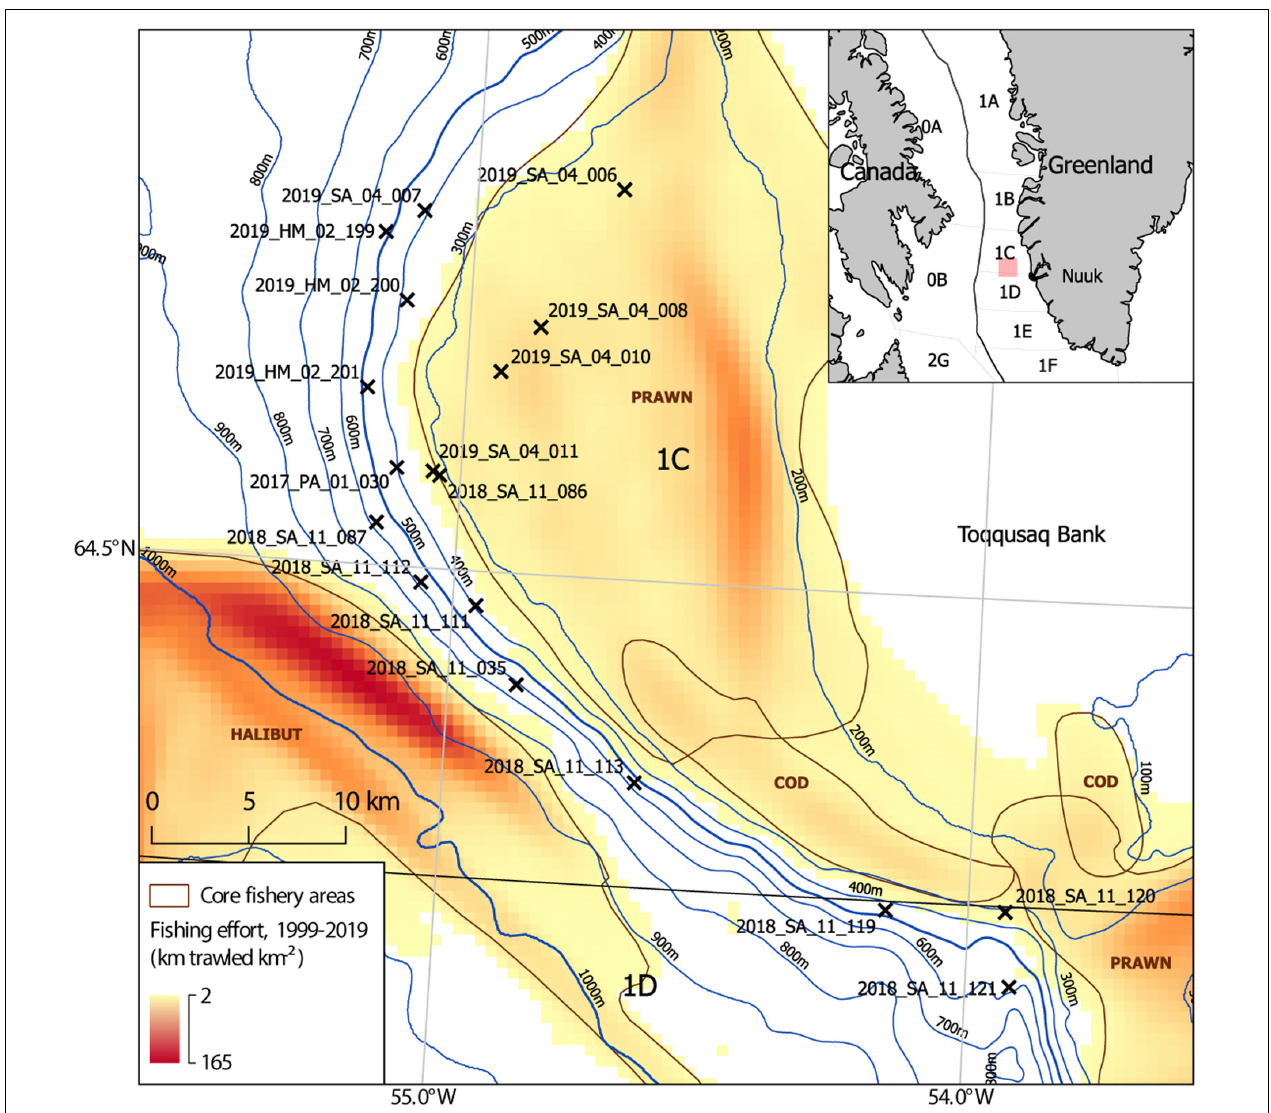
FIGURE 1 | Map of study site showing the location of benthic video sled survey stations ( n = 18), on the continental slope of the Toqqusaq Bank, west Greenland. NAFO Divisions are indicated. Video sled stations (X) are drawn at the ship’s position at the middle of each tow. The video sled station name indicates the year, vessel, cruise number, and station number (Year_Ship_Leg_Station number). The two letter ship codes indicate the RV Paamiut (PA), RV Sanna (SA), or MT Helga Maria (HM). Fishing effort is based on haul by haul logbook data from 1999 to 2019, used to determine the distance trawled per unit area (km trawled km − 2 ). The core target areas of halibut, prawn and cod trawling effort are annotated (brown), based on visual review of the effort dataset. This is intended to be